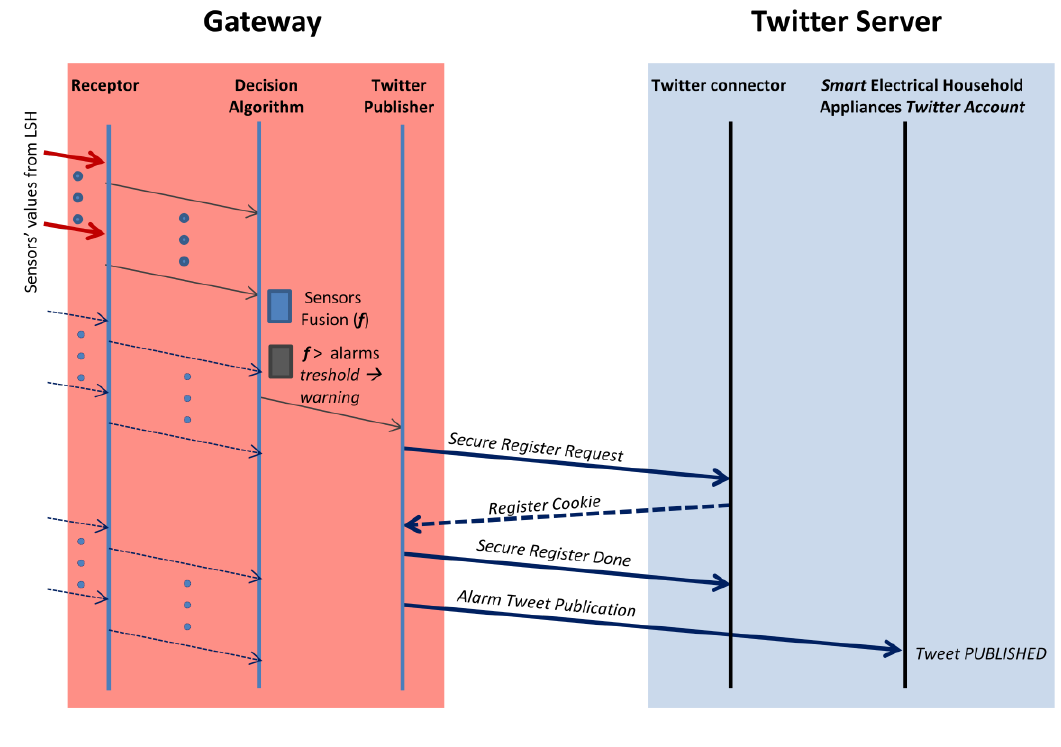
Figure 13. Communication protocol between Web Server and